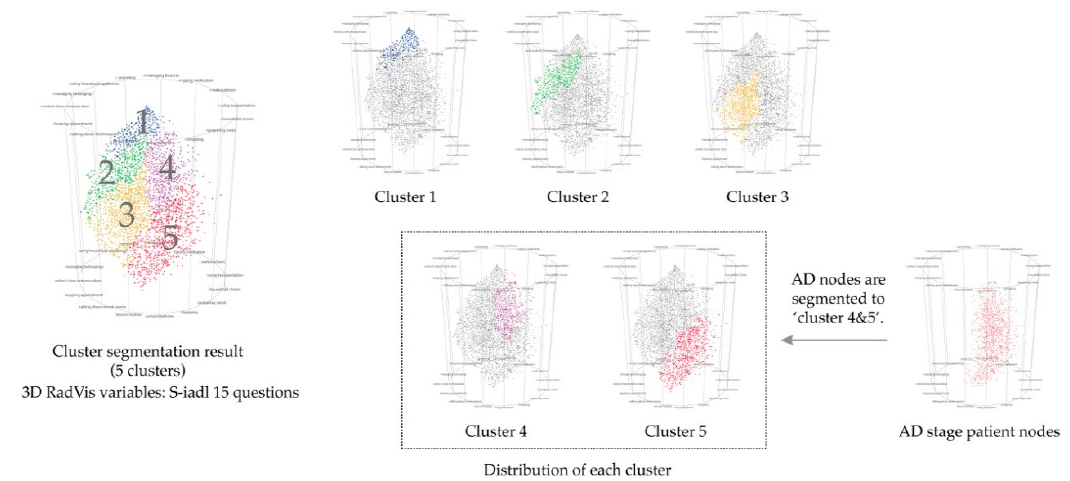
Figure 6. Result of segmenting dementia patient group into 5 clusters.